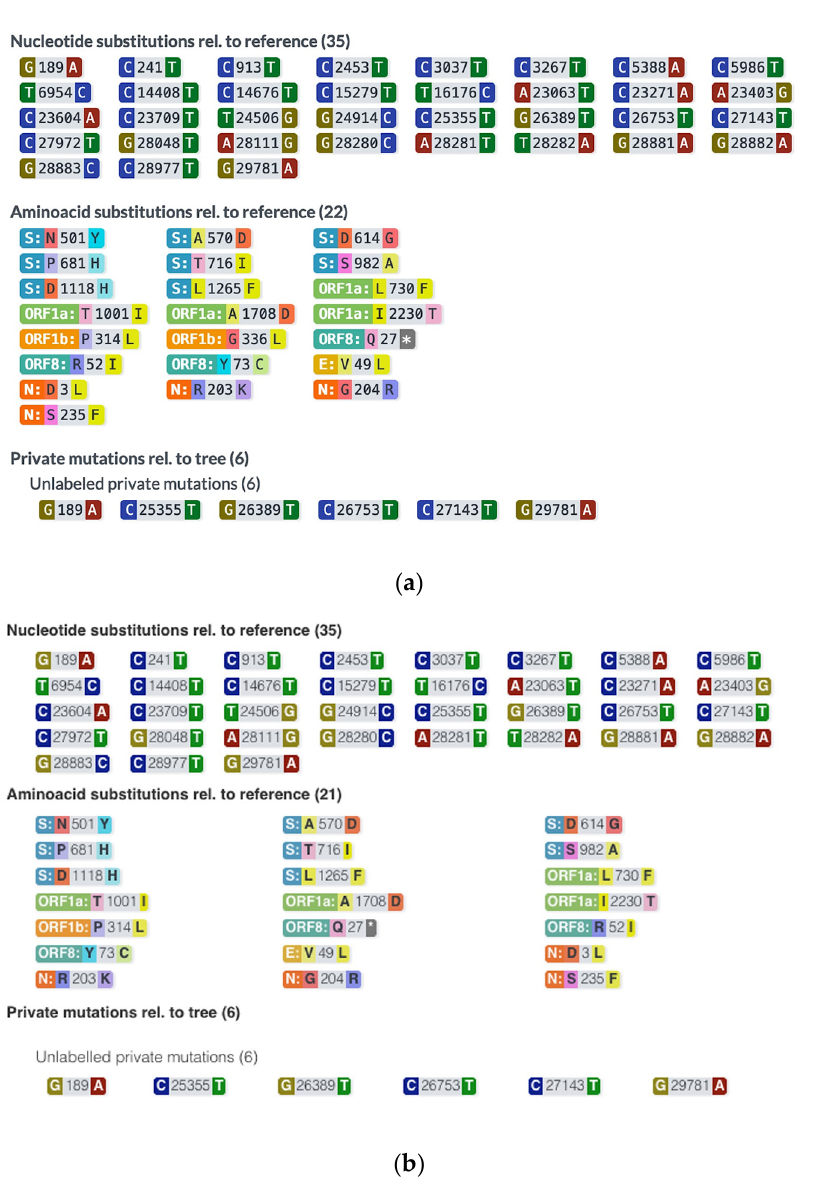
Figure 4. Mutations identified in sample 1 using Ion Torrent ( a ) and Nanopore ( b ).